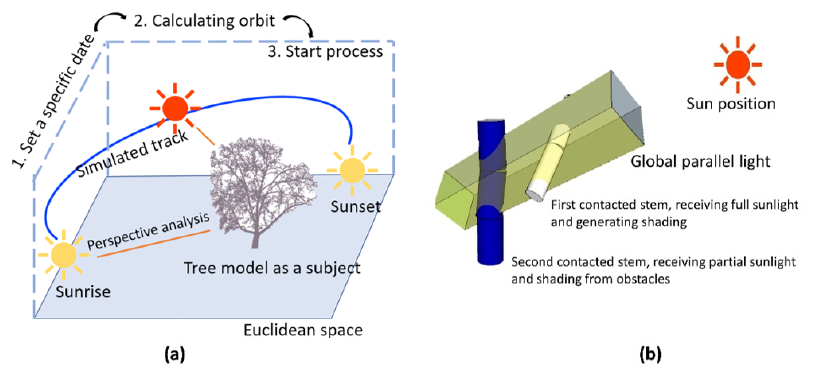
Figure 3. The procedure of CVM for single tree light conditions; ( a ) demonstration of the full process during the daytime; ( b ) detail demonstration of perspective analysis.